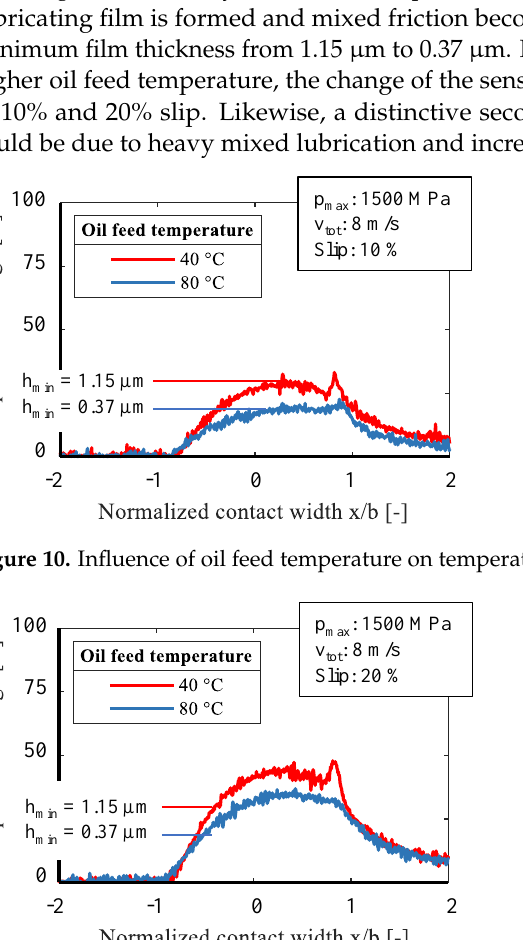
Figure 9. Comparison of slip at mixed friction.